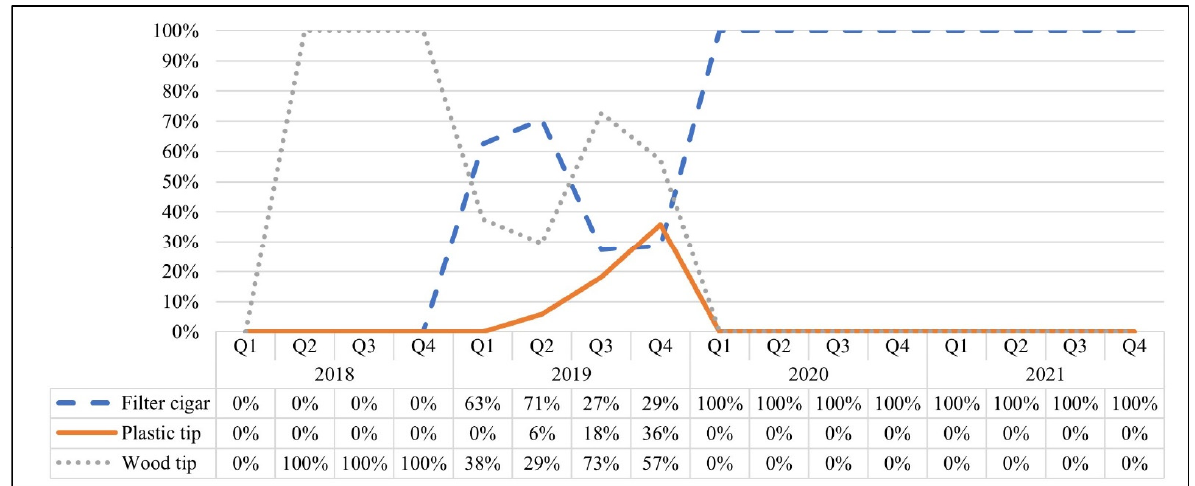
Figure 2. Percentage of Print Magazine Ad Occurrences for Black & Mild Featuring Each Cigar